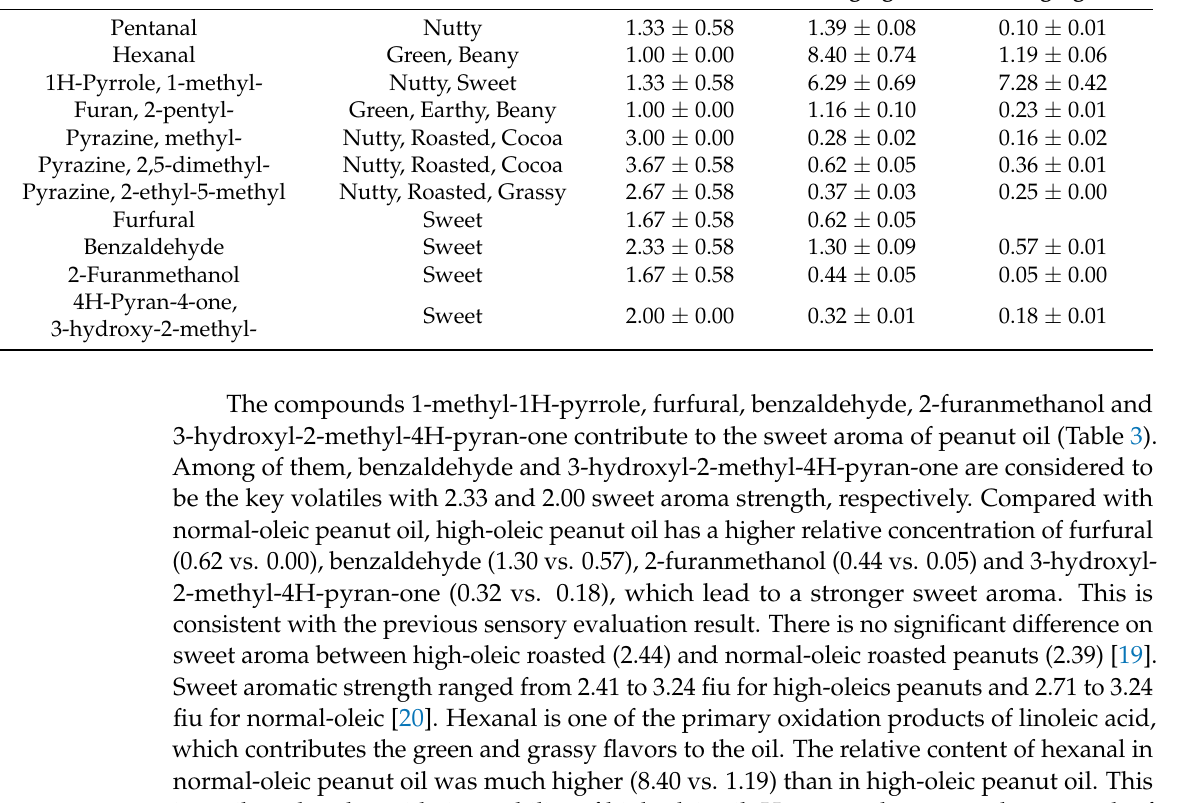
Normal-Oleic High-Oleic Peanut Oil Peanut